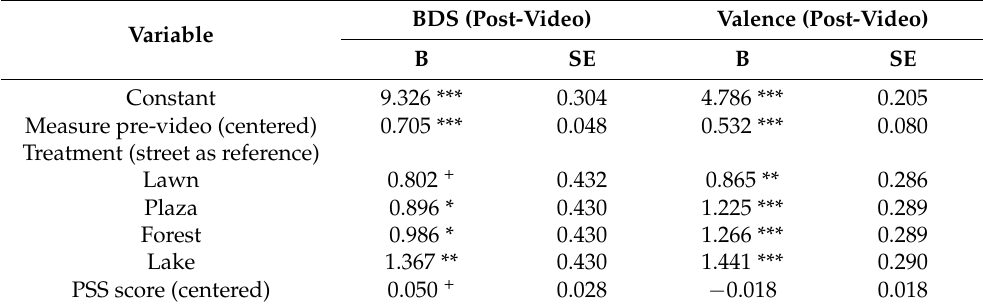
Table 2. Results of regression models testing stress symptoms (PSS-10 sum score) on BDS score and valence.